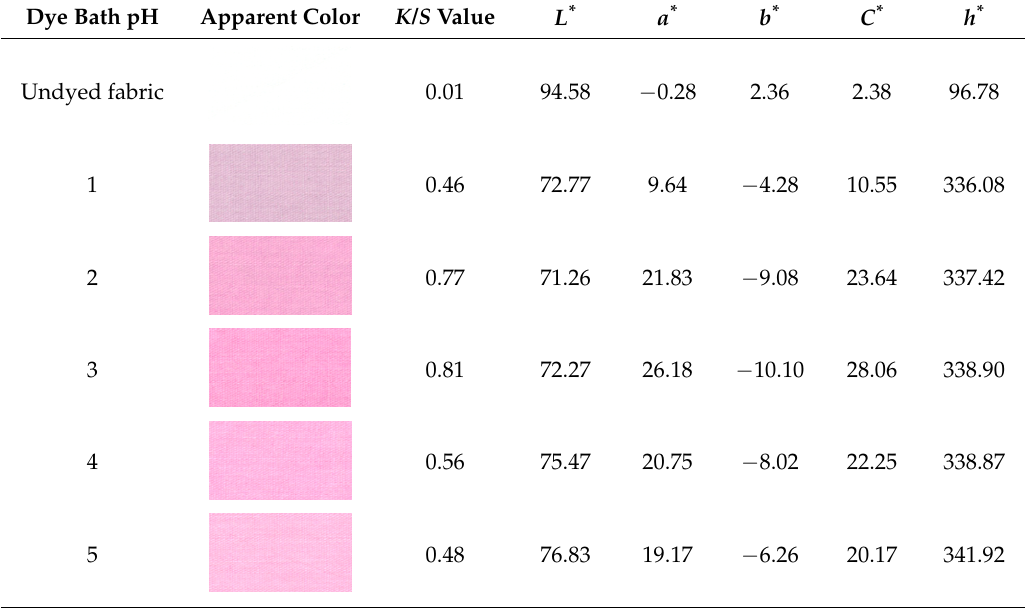
Table 1. The effect of dye bath pH on apparent color, color strength and colorimetric parameters of dyed cotton fabrics.